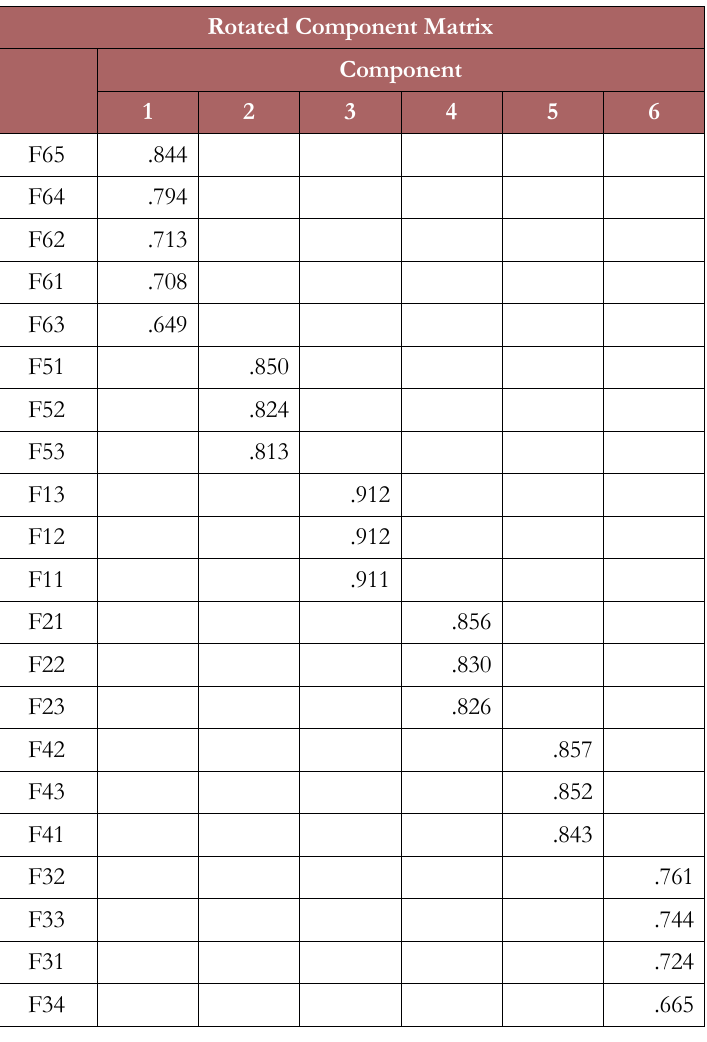
Table 3. Exploratory Factor Analysis for independent